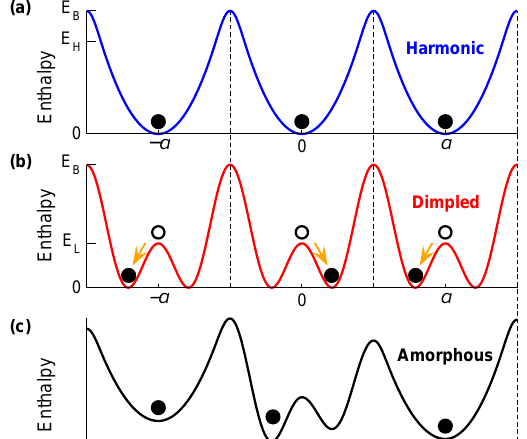
Figure 1. (color online) Schematic 1D potentials with an average lattice constant a and barriers E B for ( a ) harmonic PE (parabolic below E H ), ( b ) dimpled case with 2 local minima per basin (here, E l ≡ E L ), where at kT < E L , each atom (filled circle) is displaced (arrow) from the high-symmetry unstable position (open circle), and ( c ) glass-like amorphous